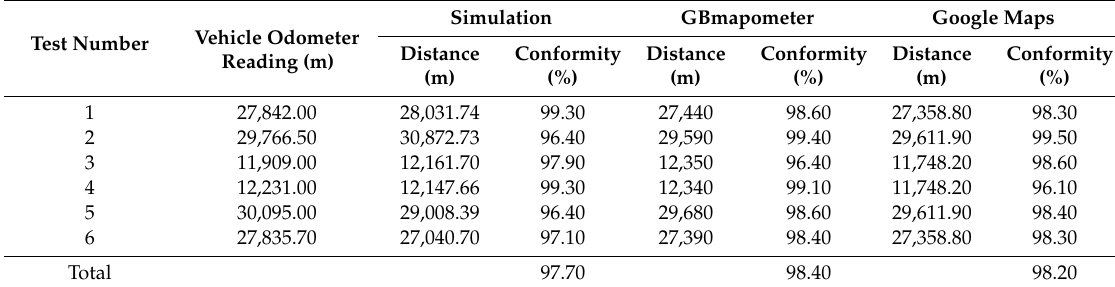
Table 7. Travelled distance comparison and error.